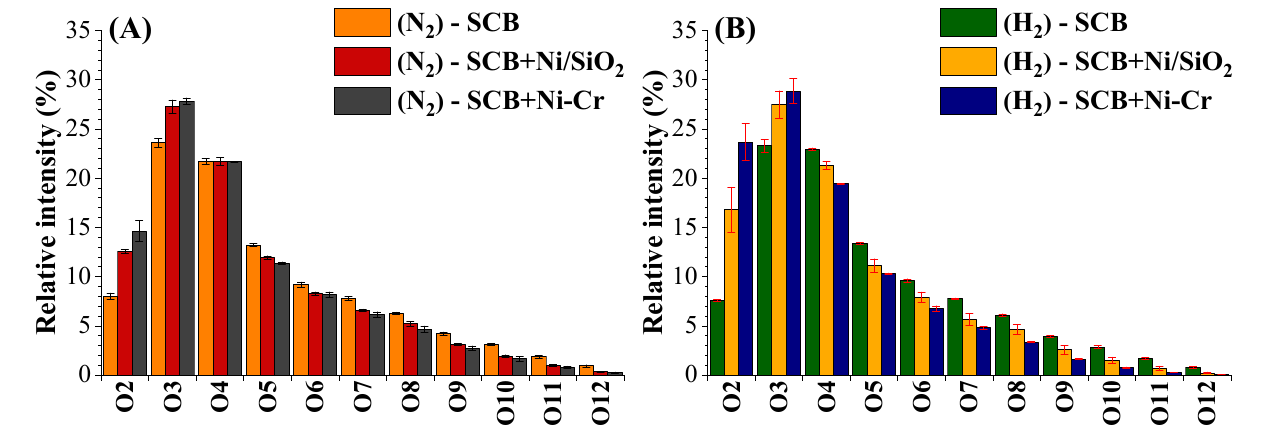
Figure 3. Histograms of classes of the LLFs produced by the processes in ( A ) inert atmosphere and ( B ) reactive atmosphere, analyzed by HESI( − )-FT-Orbitrap MS.